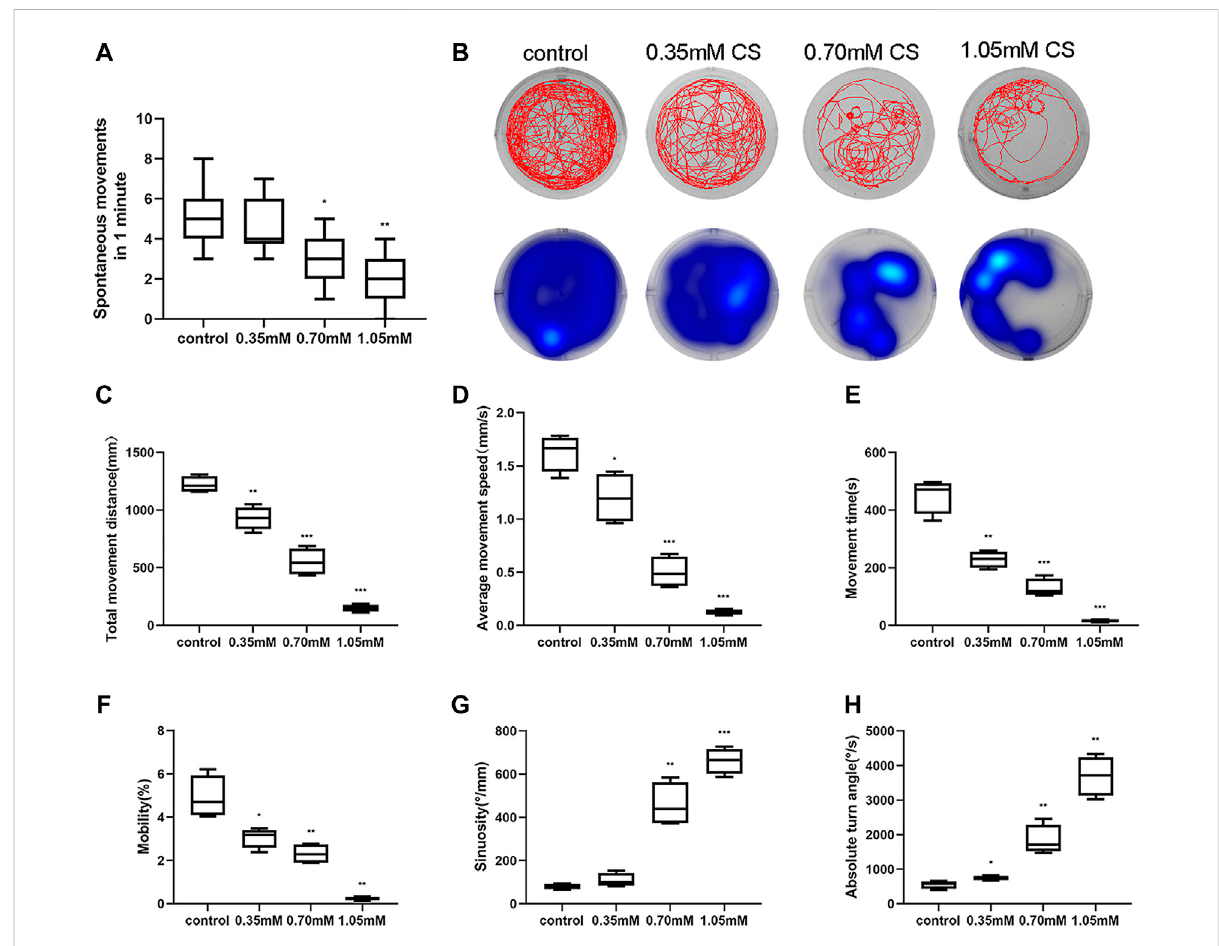
FIGURE 3 Disordering spontaneous movement and locomotor after cysteamine exposure. (A) Spontaneous tail coiling of 24 hpf embryos exposed to 0.35, 0.70, and 1.05 mM cysteamine. (B) Locomotion tracks (above) and residence time in different regions (below) of larvae exposed to 0.35, 0.70, and 1.05 mM cysteamine at 120 hpf. (C) Total distance. (D) Average speed. (E) Movement time. (F) Mobility, the frequency of high-mobile. (G) Sinuosity. (H) Absolute turn angle. The horizontal line in each box represents the average value. * p < 0.05, ** p < 0.01, *** p < 0.001, mean ±